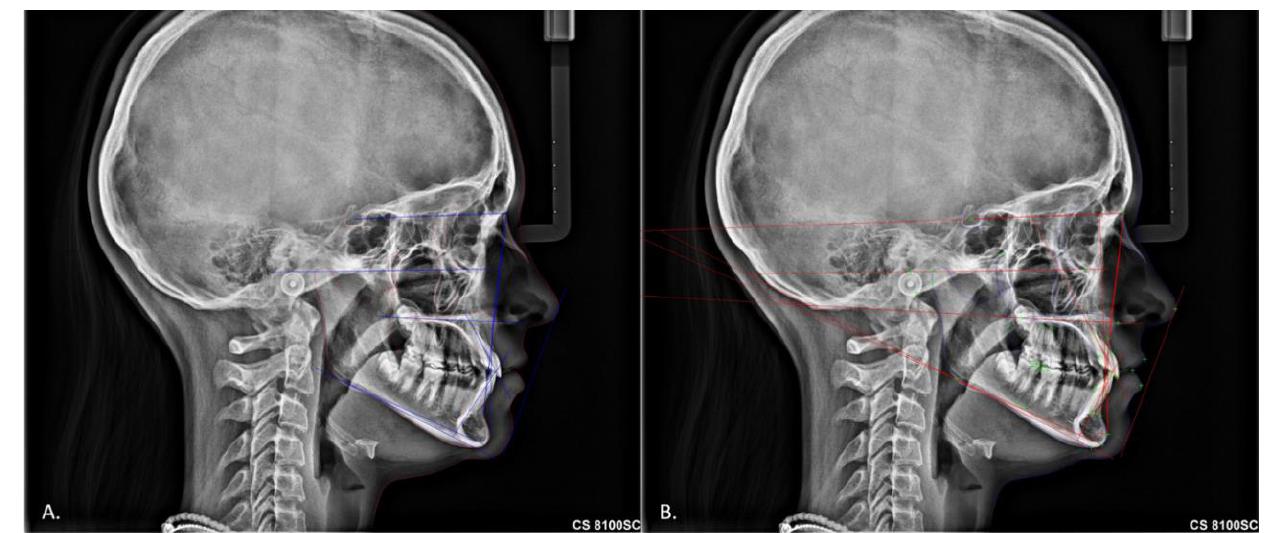
Figure 2. Cephalometric methods ( A ) Manual digital cephalometric tracing, ( B ) Automatic digital. Statistical Analysis